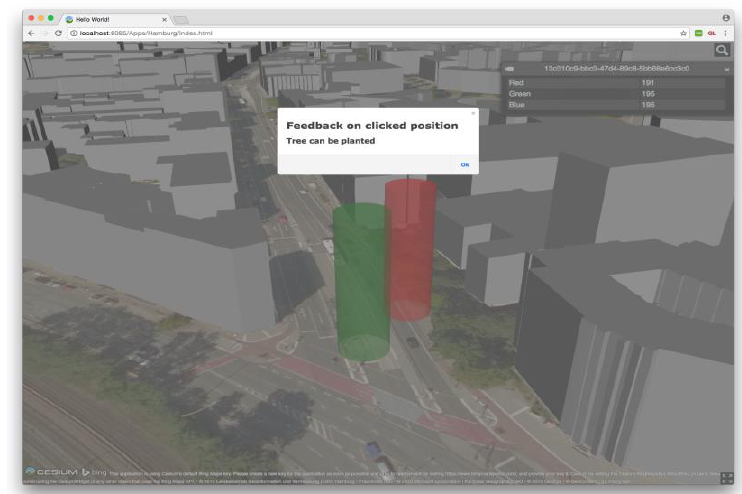
Figure 11. Positive Feedback on a selected position.